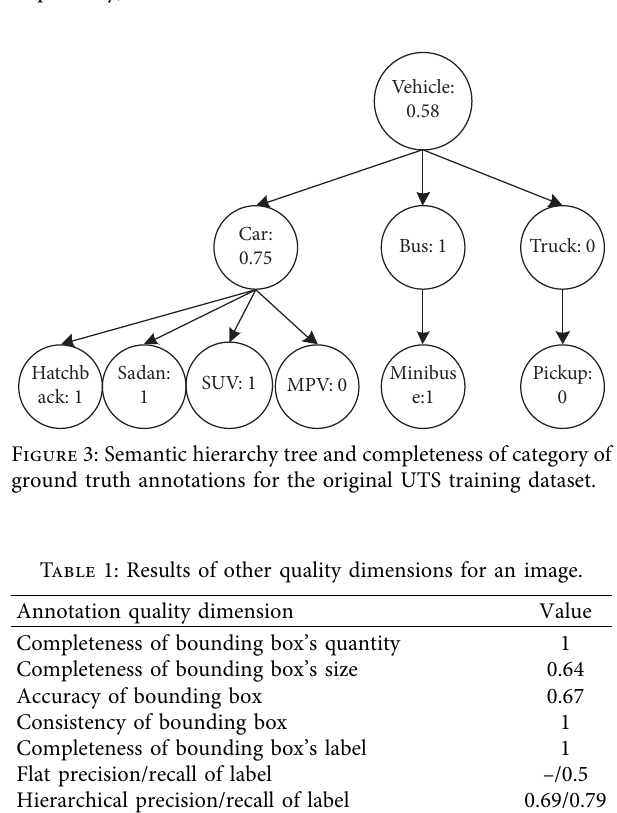
Figure 2: Human and ground truth annotations from the UTS dataset (ground truth and human annotations are shown in red and yellow, respectively).